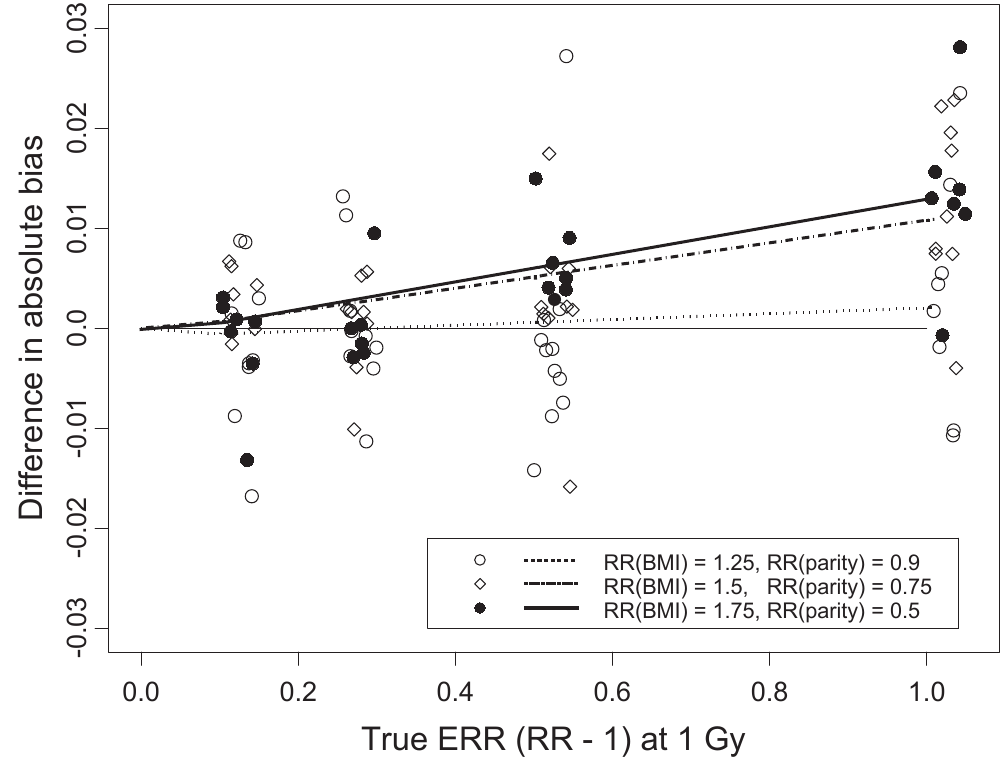
Figure 2. Simulated absolute bias: the di ff erence between that for a true excess relative risk (ERR) model parameter (calculated with the generalized nonlinear model) and that for a true logistic regression model parameter (rescaled to ERR by [exp{log(RR)} % 1], where RR is relative risk), with risk at unit dose the same under each model. Includes all simulation con fi gurations: cohort size N = 5,000 or 20,000; baseline prevalence p 0 = 0.015, 0.05, or 0.1; and control:case ratio m = 2 or 5 (although some con fi gurations could not be evaluated, as described in the text). Results for three di ff erent pairs of magnitudes of omitted-covariate e ff ect sizes are shown (see fi gure legend). BMI, body mass